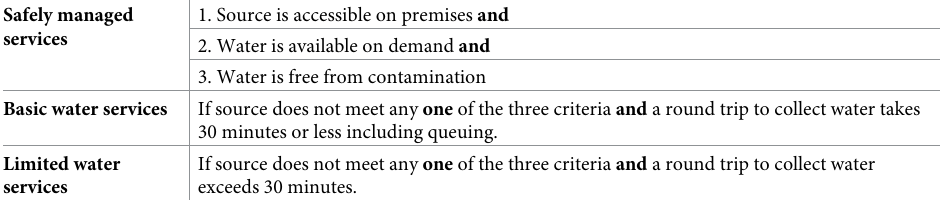
Table 1. SDG definitions for the classification of improved water